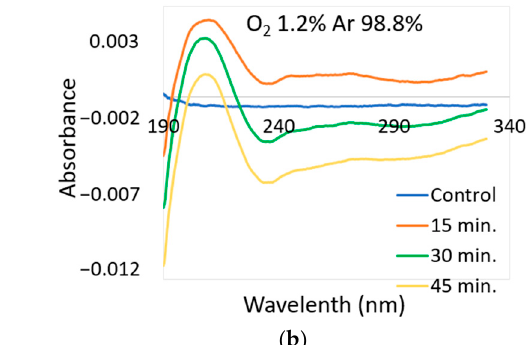
2 and 99.2% Ar; ( b ) 1.2% O 2 and 98.8%